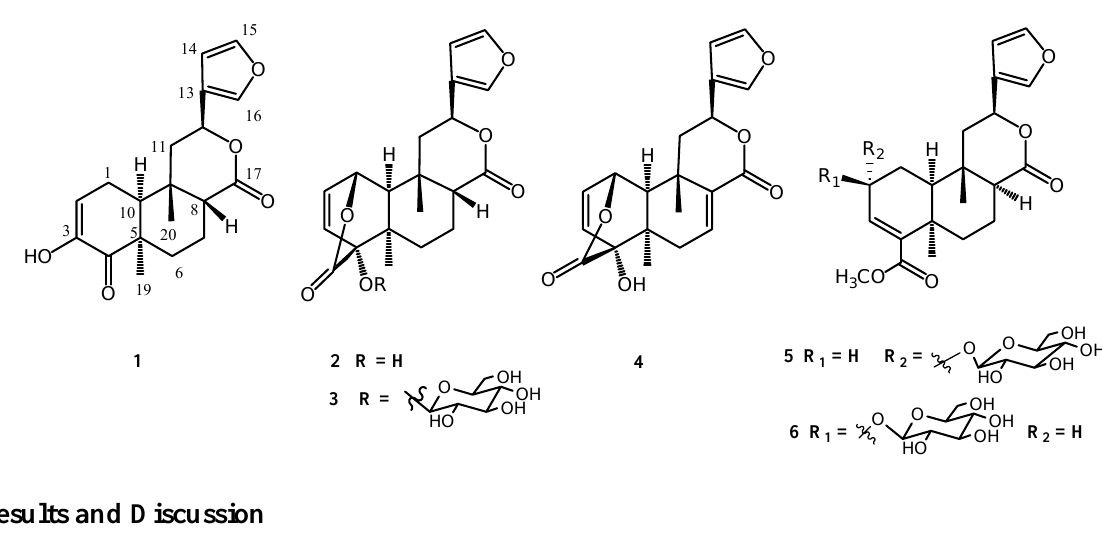
Figure 1. The structures of compounds 1–6